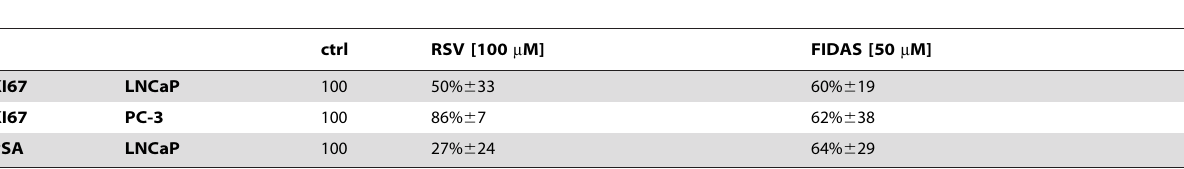
ctrl RSV [100 m M] FIDAS [50 m M] KI67 LNCaP 100 50% 6 33 60% 6 19 KI67 PC-3 100 86% 6 7 62% 6 38 PSA LNCaP 100 27% 6 24 64% 6 29 PC-3 and LNCaP cells were seeded onto the CAM to form tumors as described Material and Methods. Tumor grafts were allowed to grow for 48 hours. Subsequently, 50 m l of RSV (100 m M) or FIDAS (50 m M) were injected into a CAM-vein allowing the systemic spread of the compound. After 48 hours tumor xenografts were fixed, paraffin embedded and serially sectioned. Microtumors were stained for KI67 and PSA. Data are expressed in % of KI67 or PSA positive cells, grown in the absence of RSV or FIDAS 6 standard deviation of at least 3 independent experiments (ctrl = RSV/FIDAS untreated